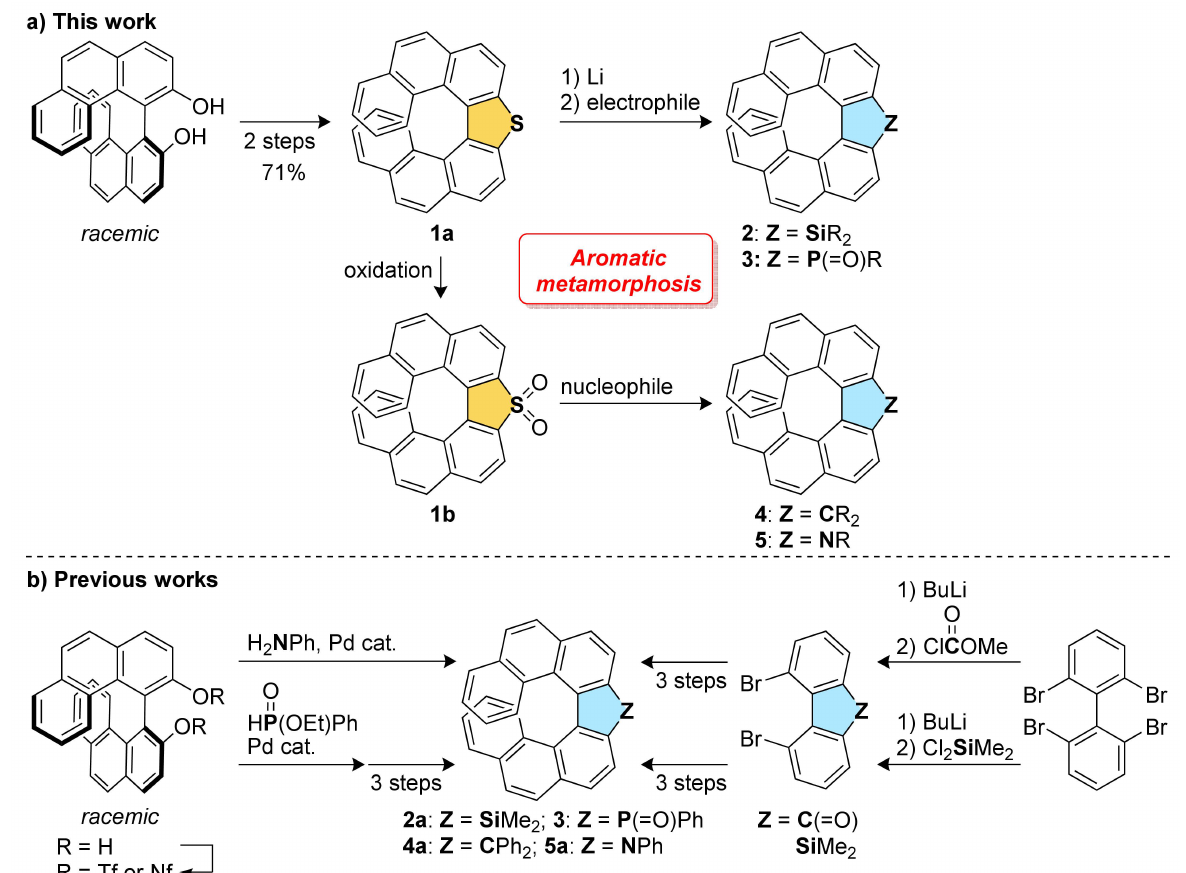
Figure 1. Synthetic routes to [7]helicenes and [7]helicene-like